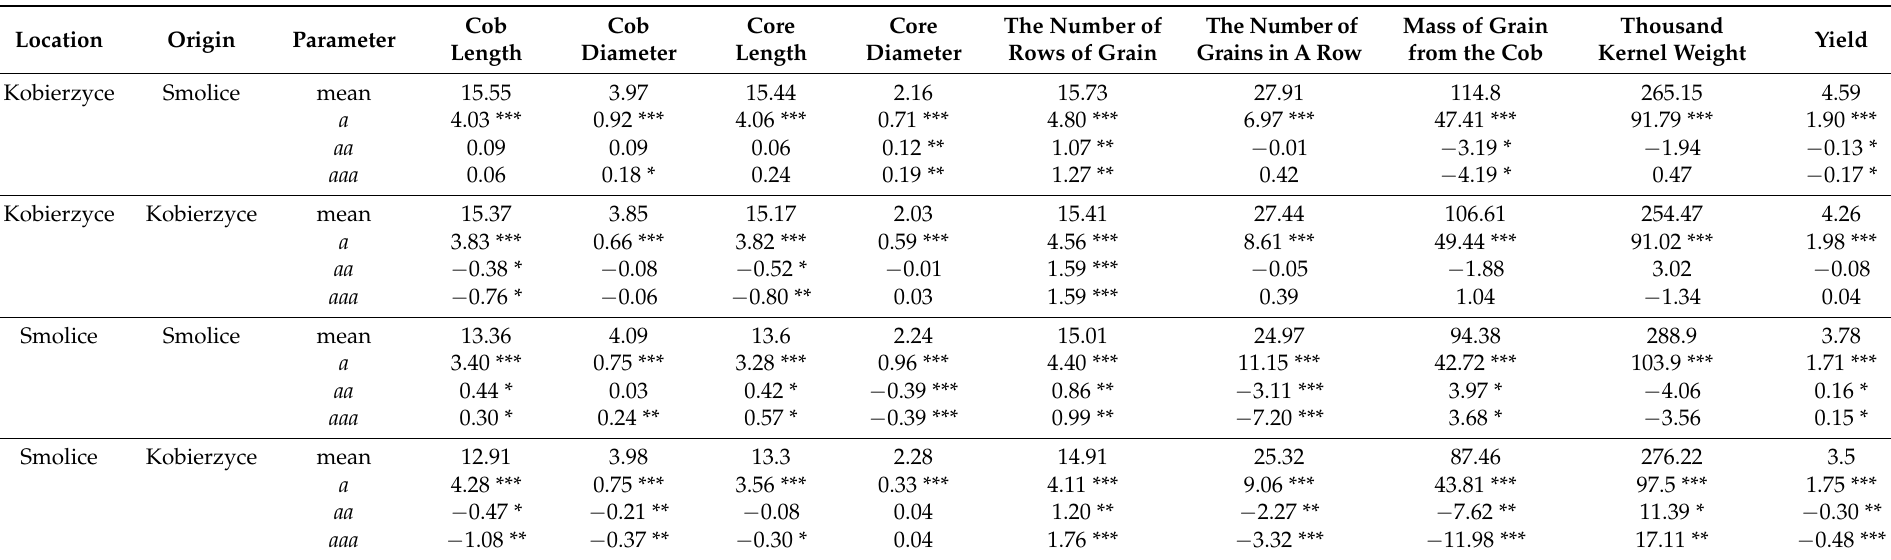
Table 1. Mean values and the total additive ( a ) effects as well as the total interaction aa and aaa effects for the 252 (151 from Smolice, 101 from Kobierzyce) inbred lines of maize estimated on the basis of only phenotypic